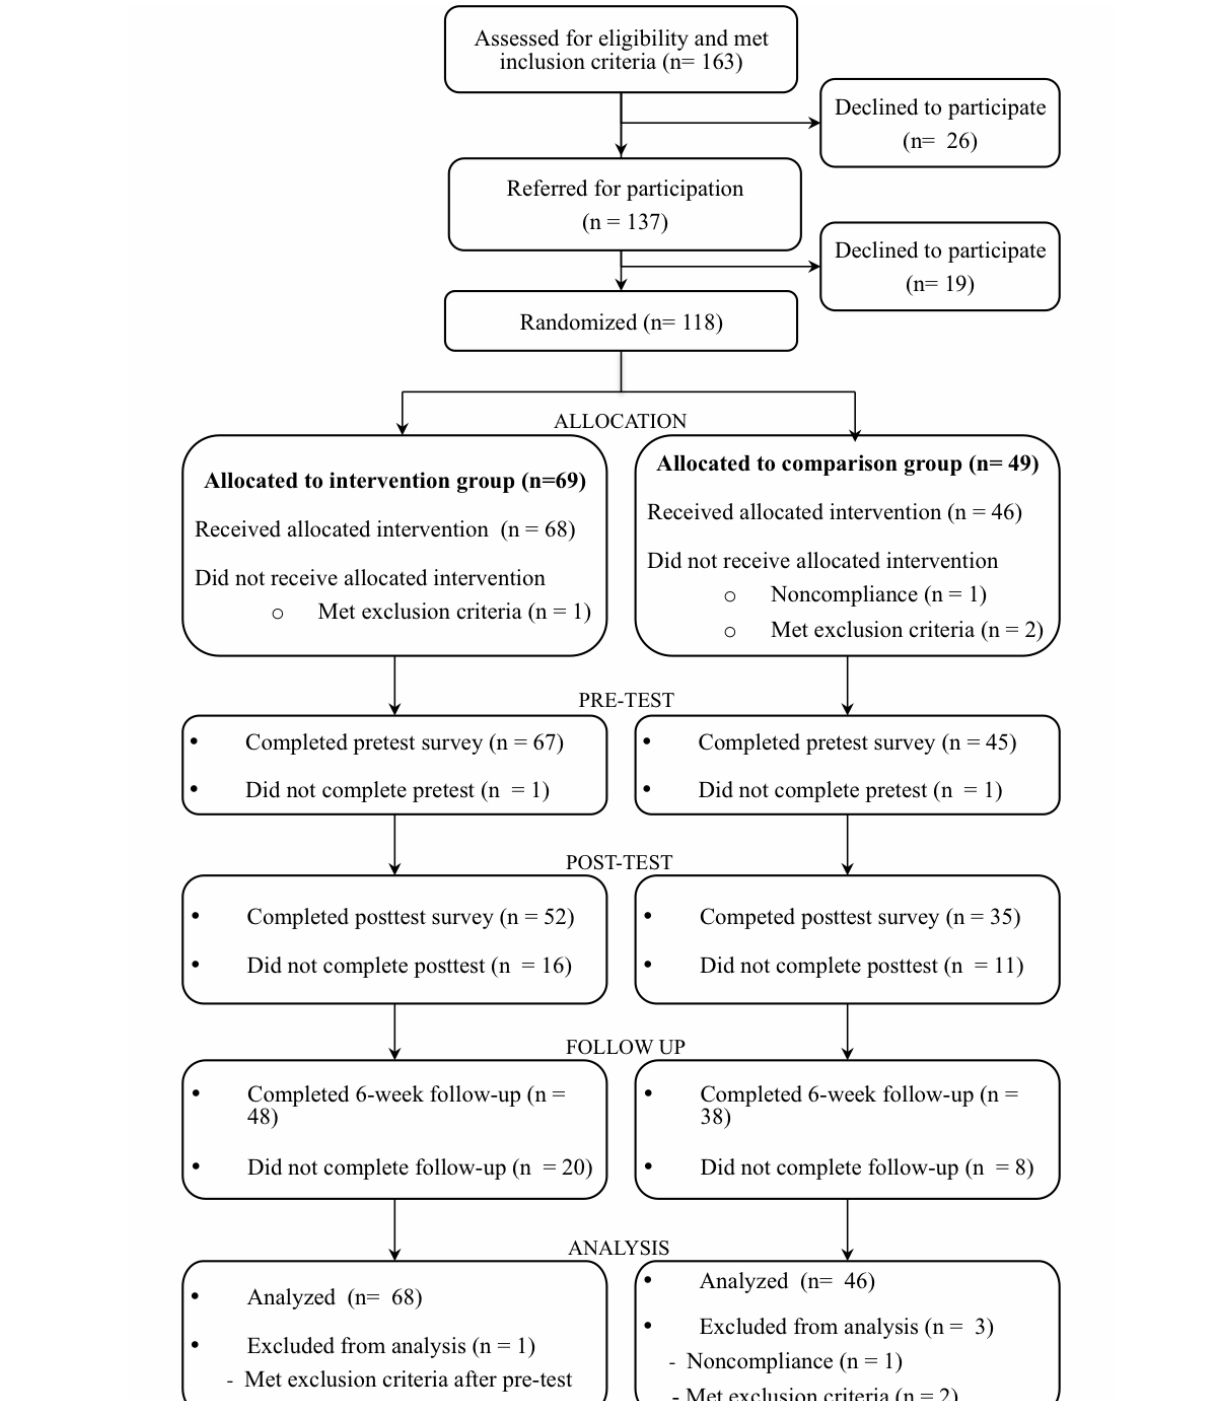
Figure 1. Flow diagram of the study